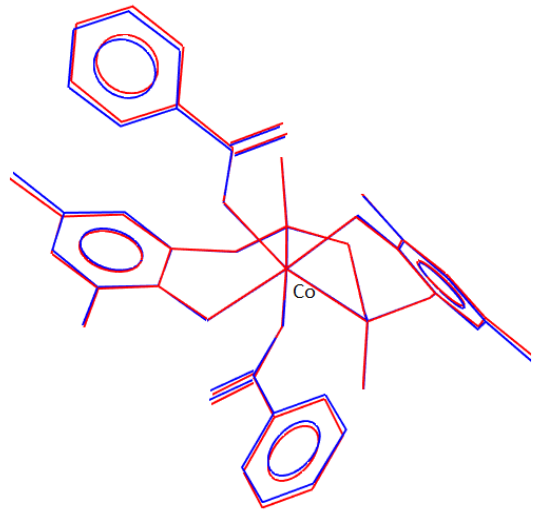
Figure 2. Superposition of two symmetry-independent molecules of 1 (red/blue).